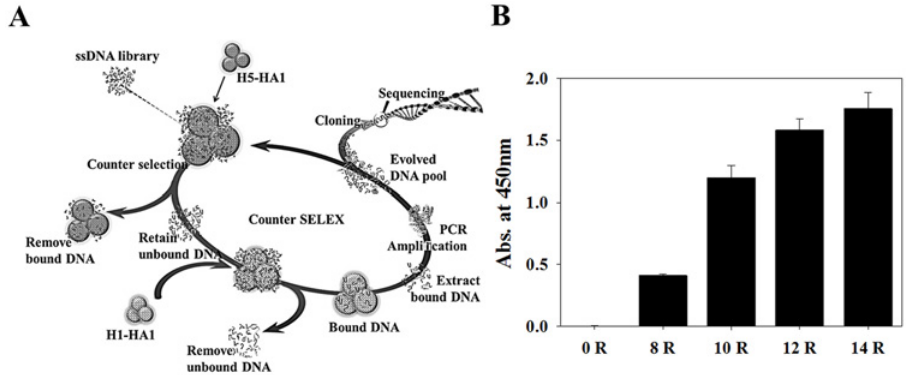
Fig 1. In vitro selection of ssDNA aptamers and specific binding activity of the ssDNA pool. (A) Schematic representation of the counter-SELEX procedure. After removing ssDNA species binding nonspecifically to glutathione agarose beads, the ssDNA pool was incubated with H5-HA1 (negative control) and centrifuged to remove H5-HA1-binding ssDNAs, after which the unbound ssDNAs were incubated with H1-HA1 (target protein), and the H1-HA1-bound DNAs were extracted using phenol-chloroform and amplified by PCR. After 14 rounds of selection, the enriched DNA was PCR-amplified, cloned, and sequenced. (B) Specific binding activity as measured by ELISA after 8, 10, 12, and 14 rounds of selection. GST-tagged H1-HA1 (100 nM) incubated on selected DNA-coated plates and analyzed using anti-GST antibody-HRP with TMB color